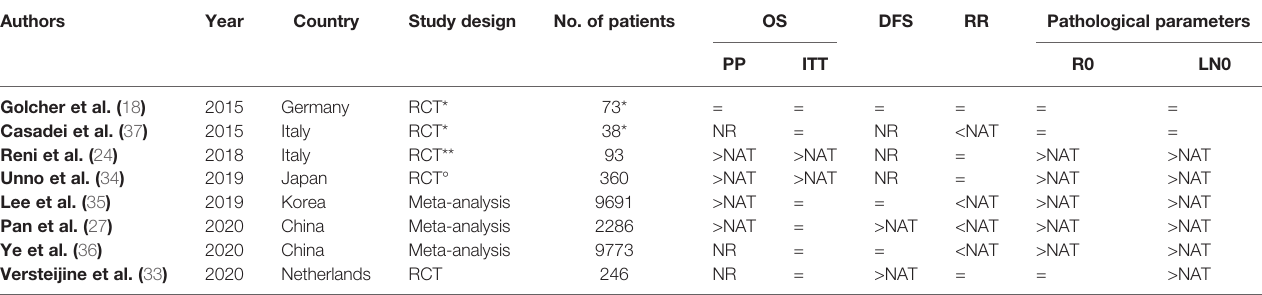
TABLE 1 | Summary of the key studies assessing NAT effectiveness in